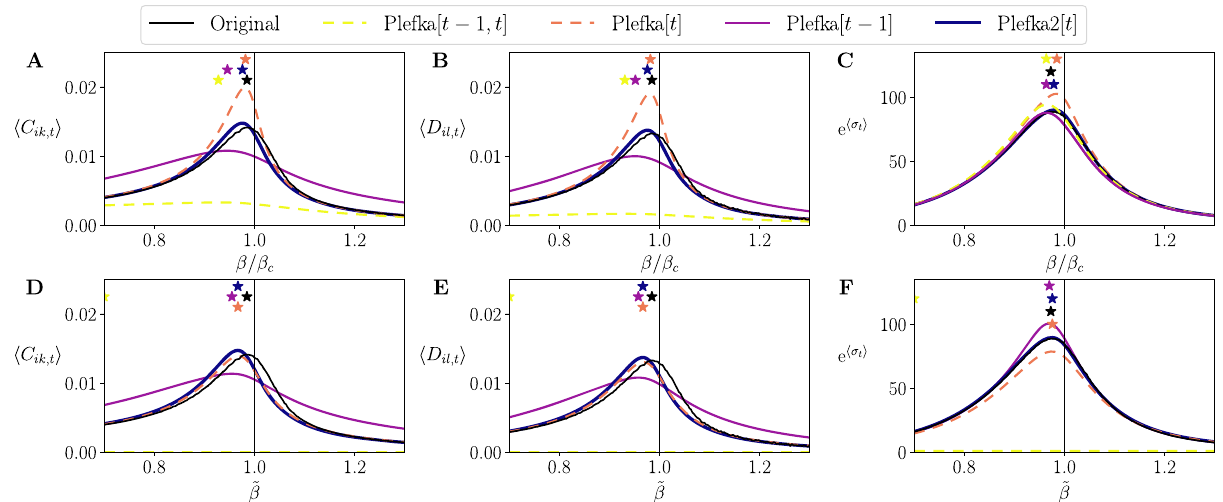
Fig. 5 Reconstructing phase transition of kinetic Ising systems. Top: Average of the Ising model ’ s equal-time correlations ( A ), delayed correlations ( B ), and entropy production (shown as an exponential for better presentation of its maximum) ( C ), at the last step t = 128 found by different mean- fi eld methods for β = β c . Bottom ( D – F ): The same as above using the reconstructed network H , J by solving the inverse Ising problem at β = β c and multiplying a fi ctitious inverse temperature ~ β to the estimated parameters. The stars are marked at the values of ~ β that yield maximum fl uctuations or maximum entropy